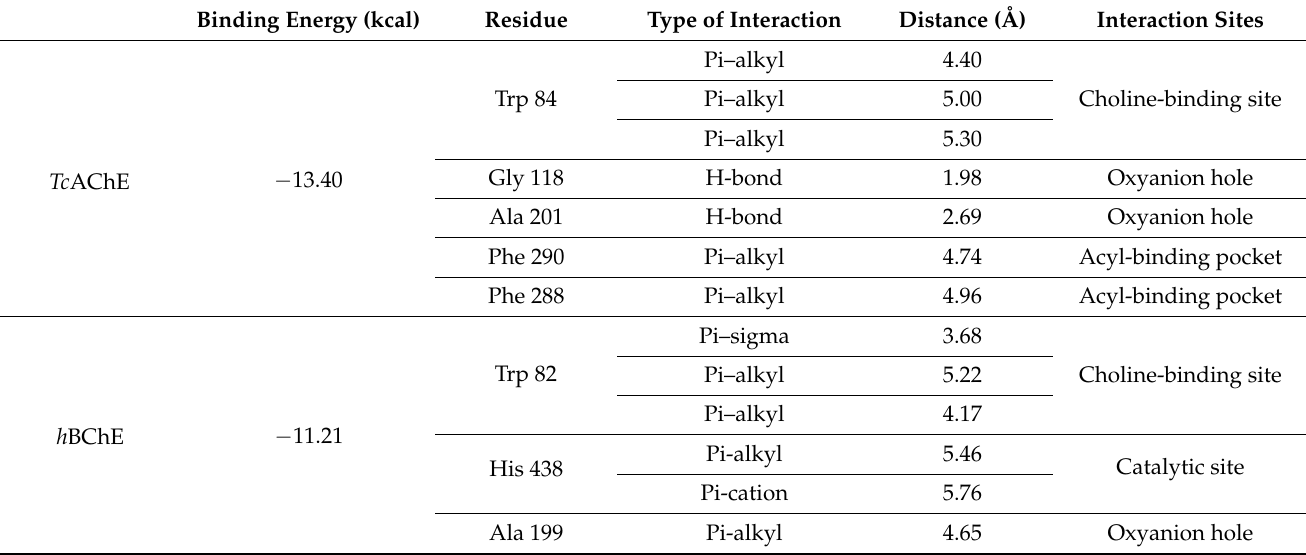
Table 3. Binding interaction data for compound ( 2 ) docked into active site gorge of T cAChE and h